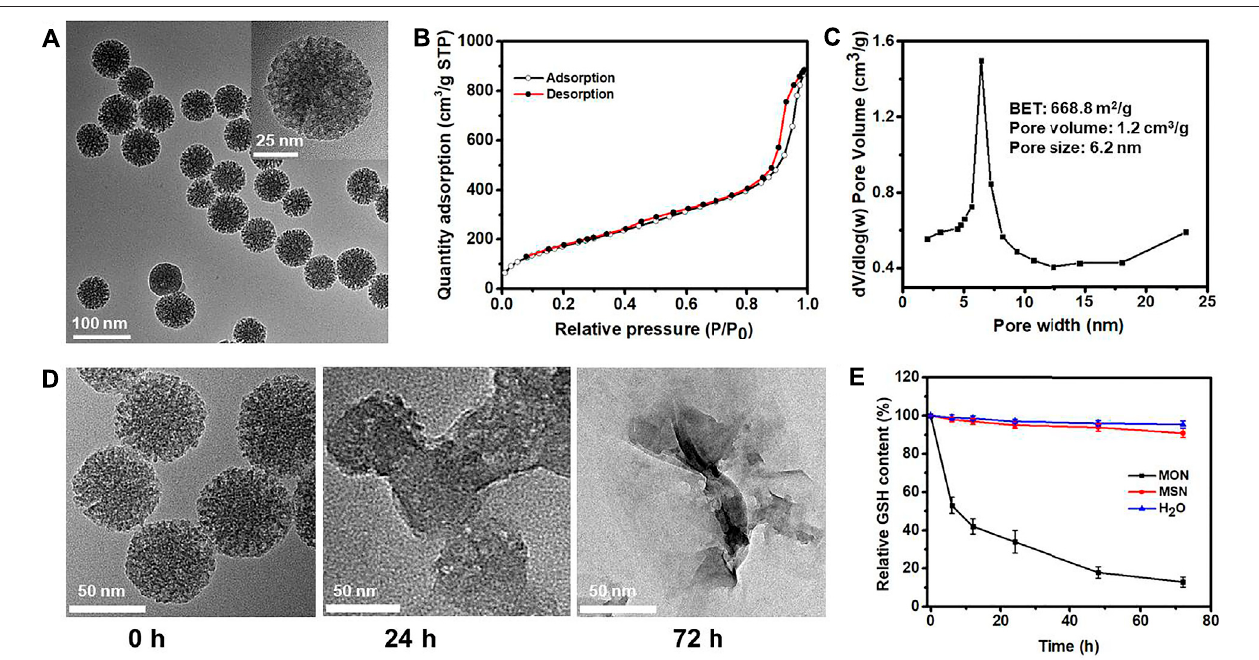
FIGURE 1 | Preparation and characterization of MON. (A) TEM, (B) N 2 adsorption isotherm, (C) pore size distribution of MON. (D) TEM images of MONs showing degradation at 0, 24 and 72 h under 10 mM GSH. (E) GSH depletion of